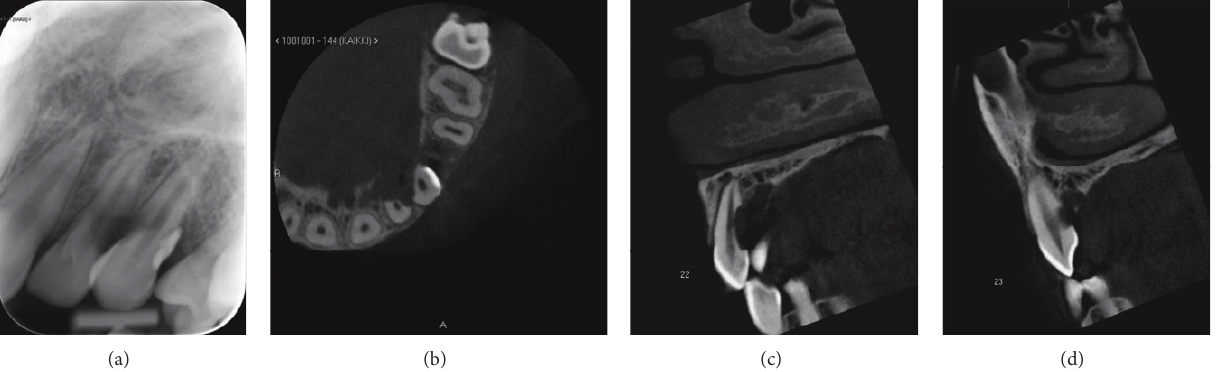
Figure 2: (a) The root resorption is visible in the intraoral X-ray of 22-23. (b) CBCT axial slice above the marginal bone line. A 6 × 10 mm bone destruction, which is sharply lined, is visible in the region 22-23 on the palatinal side. The roots of the teeth 22-23 have resorption on the palatinal sides. (c) CBCT sagittal slice presenting the root of 22. On palatinal side of the root, there is a 2 × 4 mm deep resorption defect. Lesion on palatinal bone structure can also be seen. (d) CBCT sagittal slice of 23.